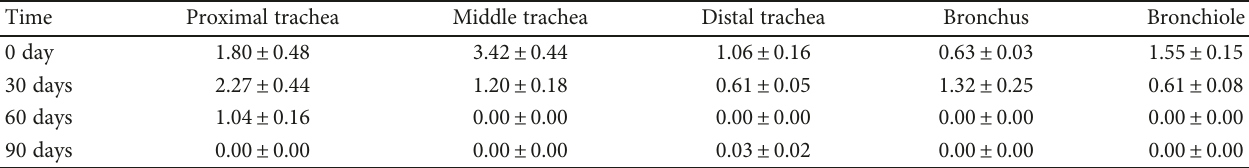
Table 3: Mean percentage of lineage-labeled Mucin 5AC-positive cells ± SEM in di ff erent regions of porcine conducting airway over a time period of 90 days